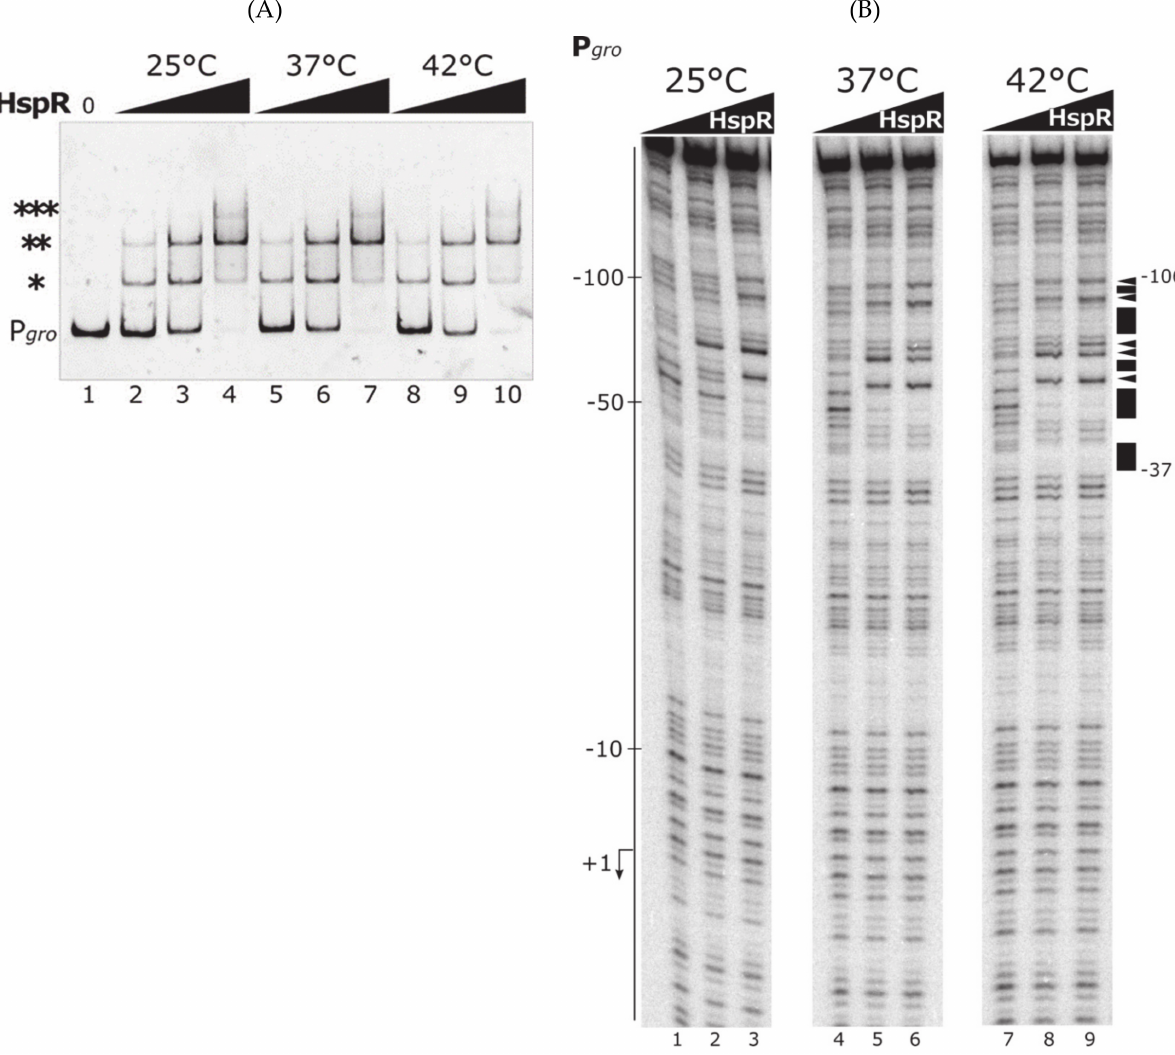
Figure 3. DNA-binding assays of the heat-shock master regulator HspR to the P gro promoter at different temperatures. ( A ) EMSA carried out with purified HspR on P gro promoter probe. DNA–protein complexes were allowed to form for 10 min at 25 ◦ C, then reactions were shifted to different temperatures (25, 37 or 42 ◦ C) for 10 min. On the left, asterisks mark the different HspR shifted bands, while the label “P gro ” indicates the free probe. Lanes 1–4 contain 0, 15, 30 and 60 nM HspR, respectively. Lanes 4–6 and 8–10 contain the same increasing concentrations of HspR as in samples 2–4. Black triangles represent increasing concentrations of HspR at the indicated temperatures; 0, no protein added. ( B ) DNase I footprinting assays with HspR on P gro labeled probe at different temperatures. Protein–DNA mixes were incubated for 10 min at 25 ◦ C, then moved to different temperatures (25, 37 or 42 ◦ C) for 10 min, before DNase I cleavage. Lanes 1–3, 4–6 and 7–9 contain 0, 30 and 60 nM HspR, respectively. Black triangles are as in panel A. On the left of the autoradiograph, the numbers refer to the positions with respect to the transcriptional start site (indicated by a bent arrow). Protected regions and DNase I hypersensitive sites are indicated on the right by black boxes and arrowheads, respectively, together with positions delimiting the HspR binding site. Symbols *, ** and *** mark HspR shifted bands. When increasing amounts of HspR were incubated with P gro at 25 ◦ C, several shifted bands, characterized by different electrophoretic mobilities, appeared. At low protein concentration, two retarded bands (Figure 3A, lanes 2 and 3, indicated by * and ** symbols) became evident, while a third shifted band appeared only at the highest HspR